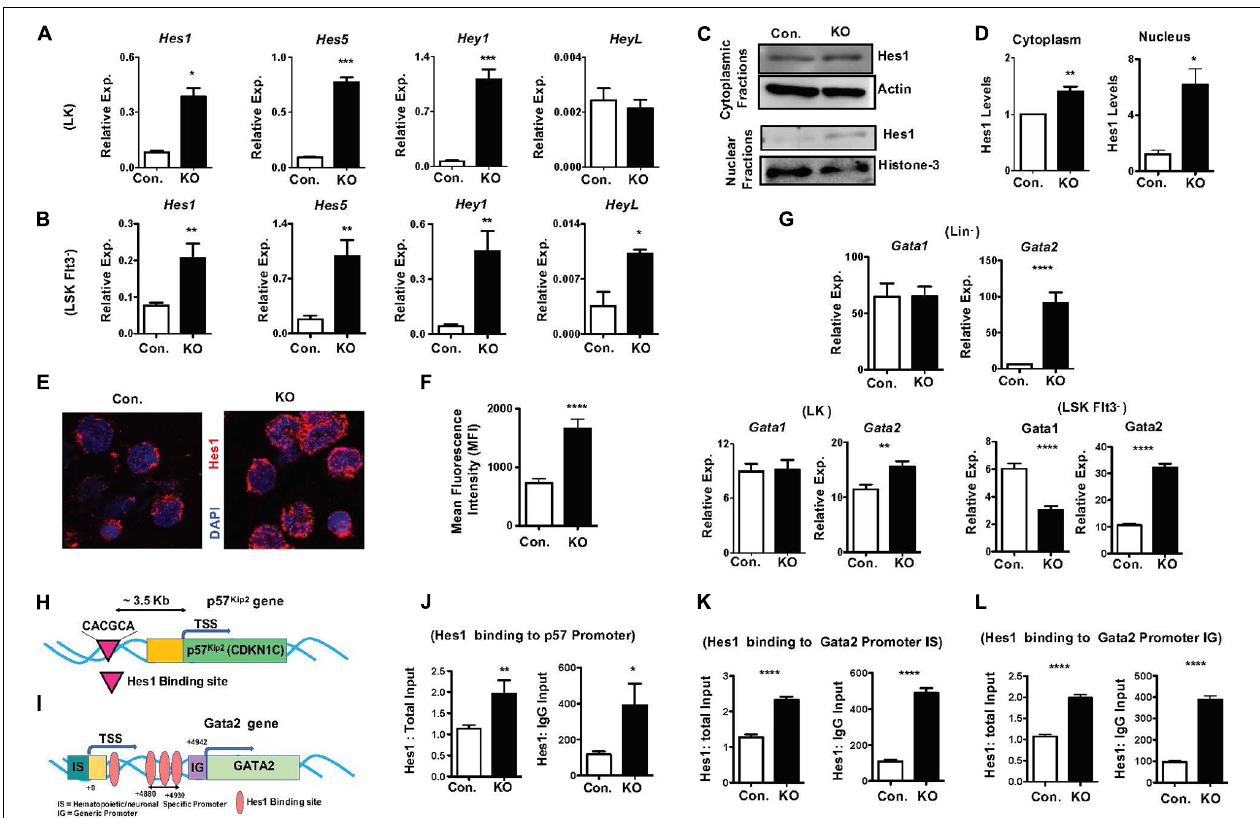
FIGURE 6 | Lack of Rbpj leads to augmented expression and activity of notch target genes. (A,B) Real time PCR analysis of notch target genes in purified LK (A) and Flt3 − LSK (B) cells of BM from KO and control mice. Expression levels were normalized to HPRT levels. Data are representative of three independent experiments. (C) Western blot analysis of Hes1 proteins in the cytoplasm and nucleus of Lin − BM cells of KO and control mice. Data are representative of three independent experiments. (D) Quantification of proteins from western blots shown in (C) cytoplasmic Hes1 protein levels were normalized to actin protein levels and nuclear Hes1 protein levels were normalized to Histone-3 protein levels in each lane, respectively. Data are pool of three independent experiments. (E) Representative immunofluorescence images of Hes1 and DAPI in purified Lin − c-Kit + BM cells of KO and control mice. (F) Quantification of nuclear Hes1 levels from (E) . Data points include n = 30–40 individual cells from two independent experiments. (G) Real time PCR analysis of Gata1 and Gata2 mRNA levels in purified Lin − , LK and Flt3 − LSK cells of BM from KO and control mice. Expression levels were normalized to HPRT levels. Data are representative of two independent experiments. (H) Diagrammatic representation of p57 Kip 2 gene indicating the presence of Hes1 binding site in the 5 (cid:48) upstream of its promoter. (I) Diagrammatic representation of Gata2 gene indicating the presence of four Hes1 binding sites in both hematopoietic/neuronal specific promoter (IS) and generic promoter (IG) regions of Gata2. (J) ChIP analysis of Hes1 binding to the regulatory regions of p57 Kip 2 in purified Lin − cells of BM from KO and control mice. Shown are the real-time PCR data of Hes1 immunoprecipitates, which were normalized to either total input (left) or IgG control (right) immunoprecipitates. Data are representative of two independent experiments. (K,L) ChIP analysis of Hes1 binding to the IS (K) and IG (L) promoter regions of Gata2 in purified Lin − cells of BM from KO and control mice. Shown are the real-time PCR data of Hes1 immunoprecipitates, which were normalized to either total input (left) or IgG control